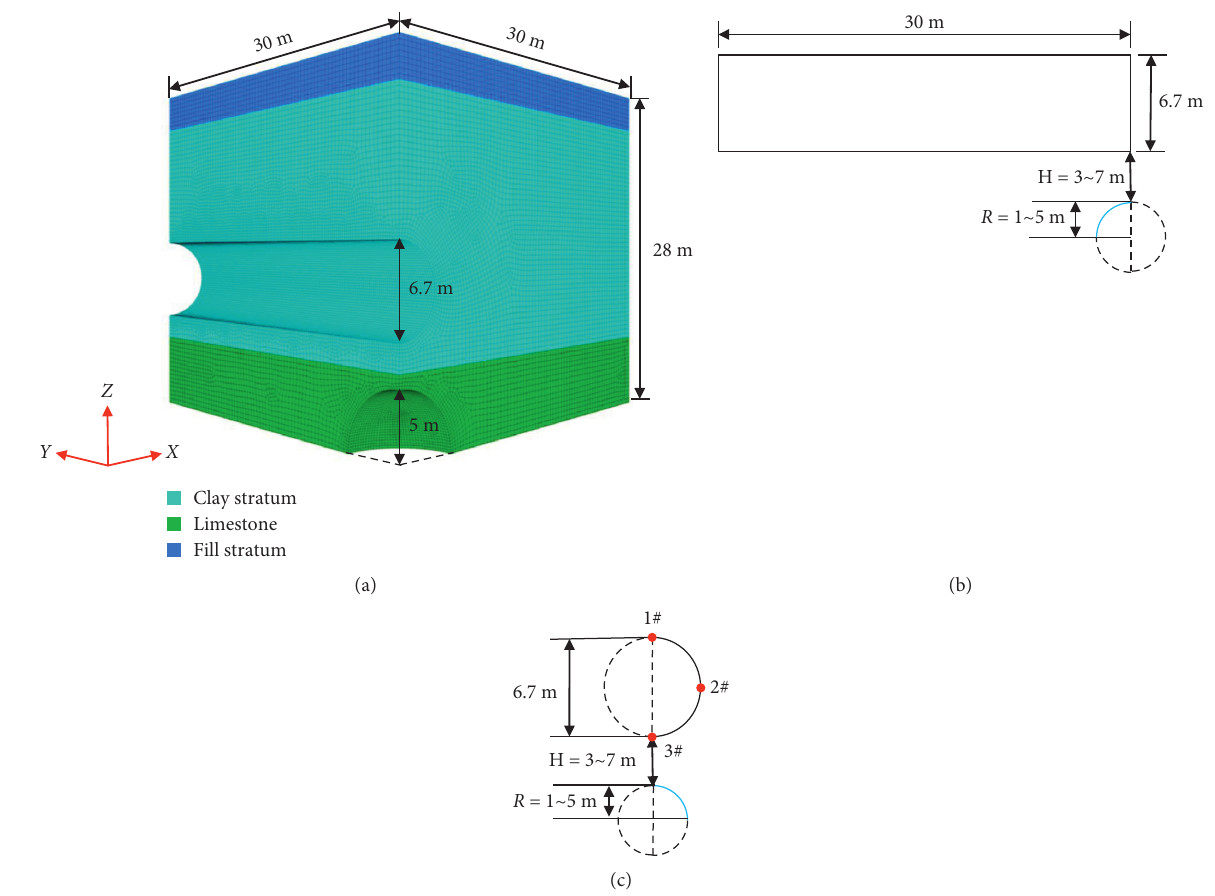
Figure 7: Numerical model and relative positions of the karst cave and tunnel. (a) Numerical model. (b) YZ -section. (c) monitoring line #2, and tunnel bottom monitoring line #3 (red point in Figure 7(c)).